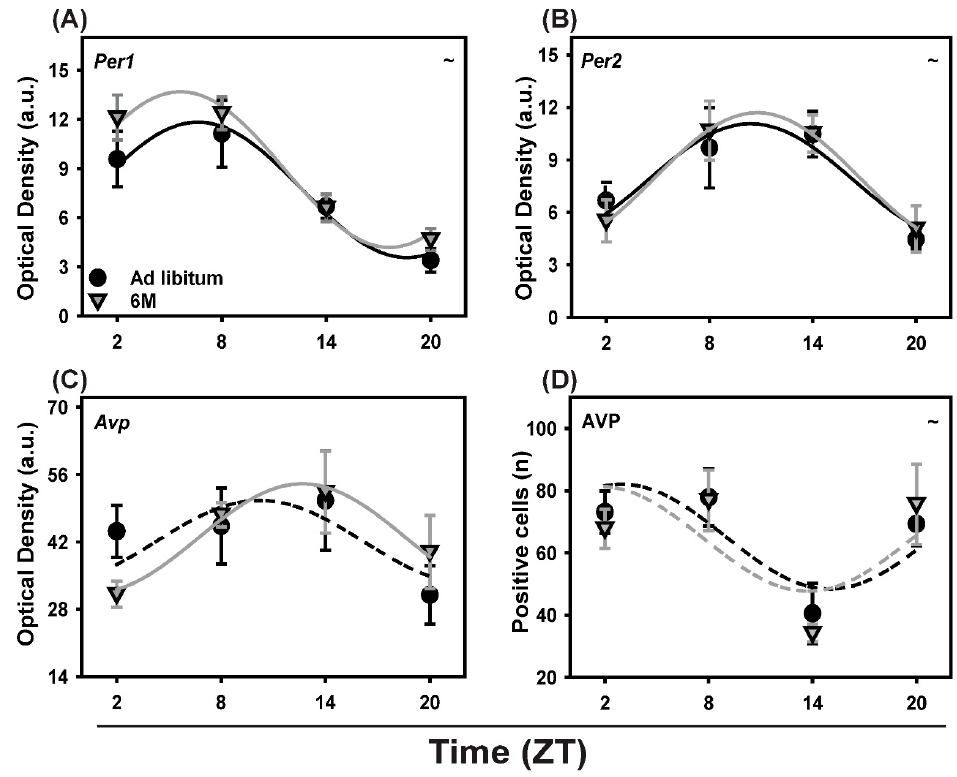
Figure 4. Daily profiles of clock (Per1, Per2) and clock-controlled (AVP) genes and AVP protein expression in the SCN of animals fed ad libitum (Black circles) and according the 6-meals-a-day feeding schedule (Gray triangle). ( A ) Per1 mRNA expression; ( B ) Per2 mRNA expression; ( C ) Avp mRNA expression ( D ) AVP protein expression. Fitted lines show significant cosine regressions (see methods). ~ = effect of Time ( p < 0.05).